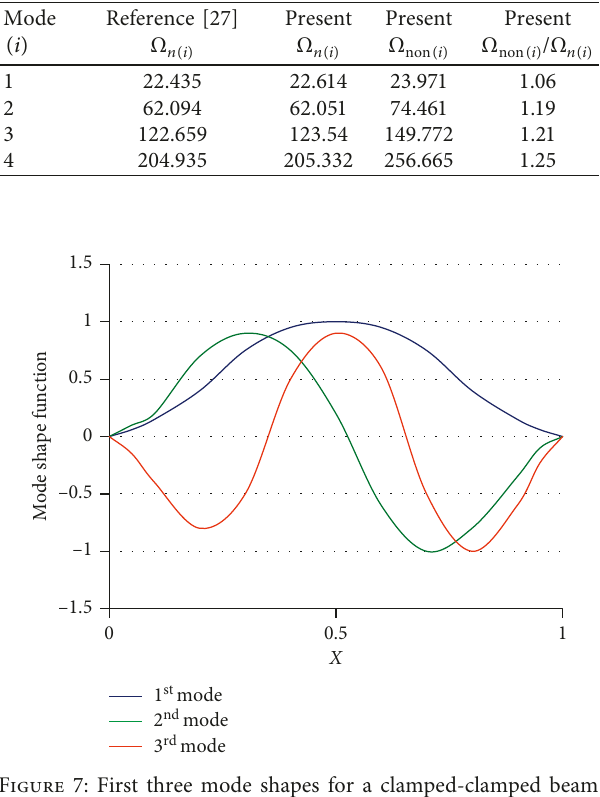
Figure 7: First three mode shapes for a clamped-clamped beam � 1 and P � 1. with K 0